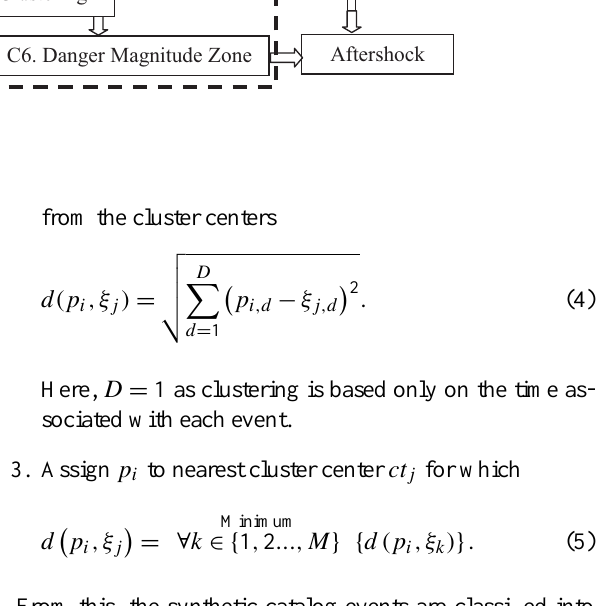
Fig. 2. Block diagram of proposed tri-stage cluster identification model